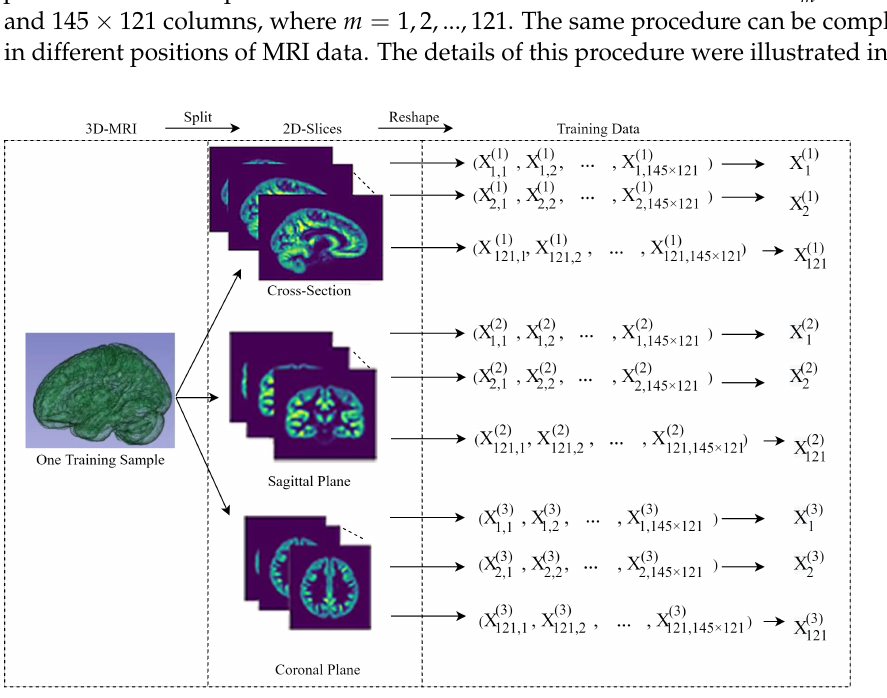
Figure 1. Segmentation of the 3D-magnetic resonance imaging (MRI) training